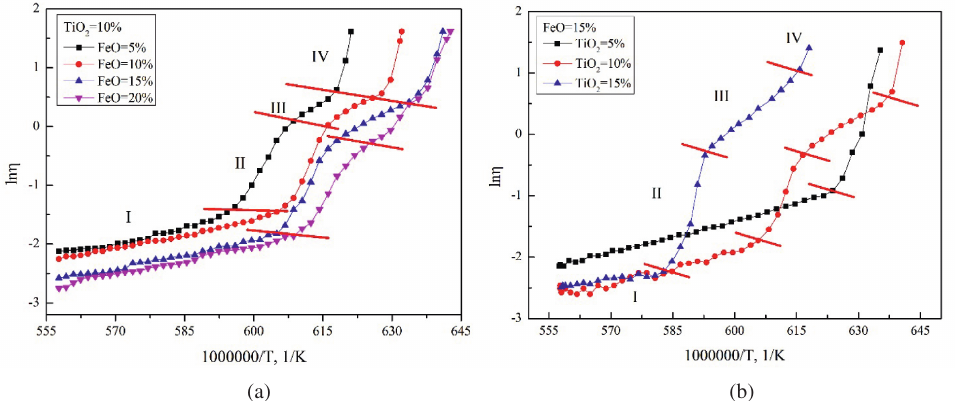
Figure 8. The curve of ln η changing with FeO and TiO can be divided into four periods according to the increase rate. In this study, the viscosity curves derivative of the temperature are conducted and the turning points are regarded as the dividing location. Those four periods are named slow period (I), rapid period (II), slow down period (III) and dramatically rise period